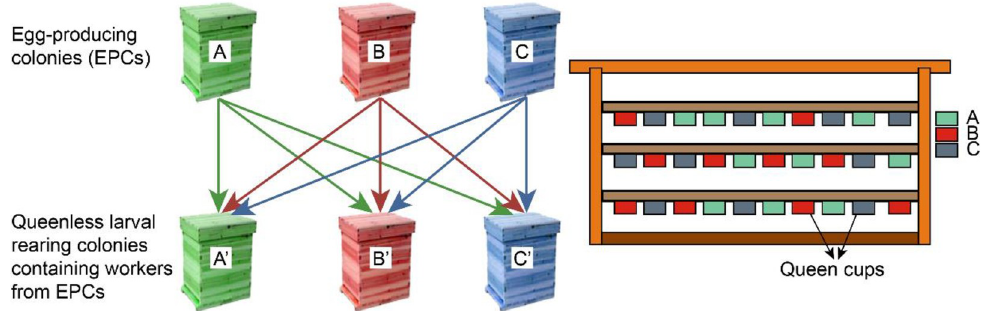
Fig 1. Illustration of experimental design used in the study.